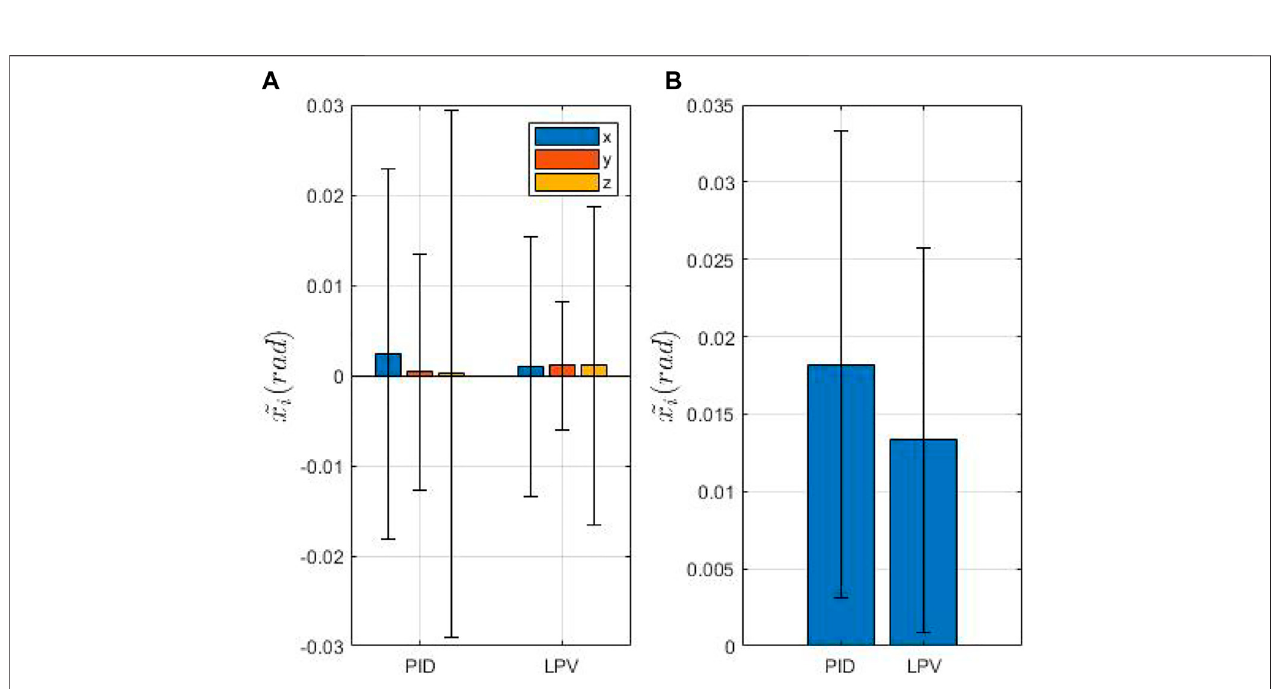
FIGURE 7 | Overview of the IPM orientation error at 15 cm of inter-magnetic distance. (A) shows the mean and standard deviation of the orientation error. (B) shows the mean and the standard deviation of the euclidean norm of the mean orientation error.